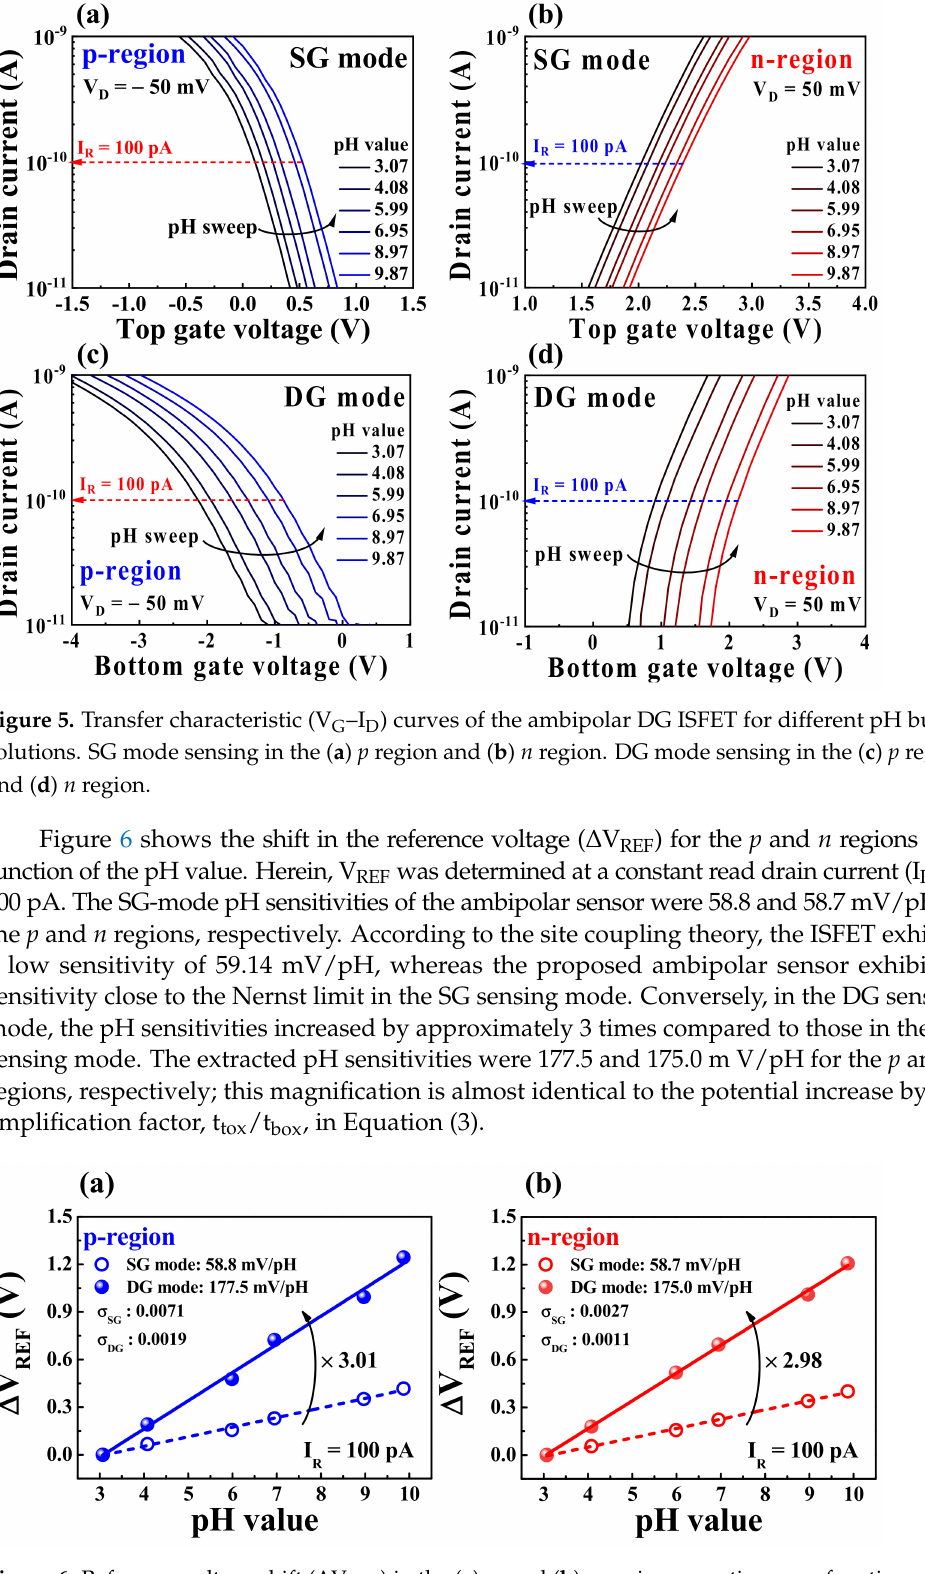
Figure 6. Reference voltage shift ( ∆ V REF ) in the ( a ) p - and ( b ) n -region operations as a function of the pH value. The symbols and lines represent the experimental data and linear fits,